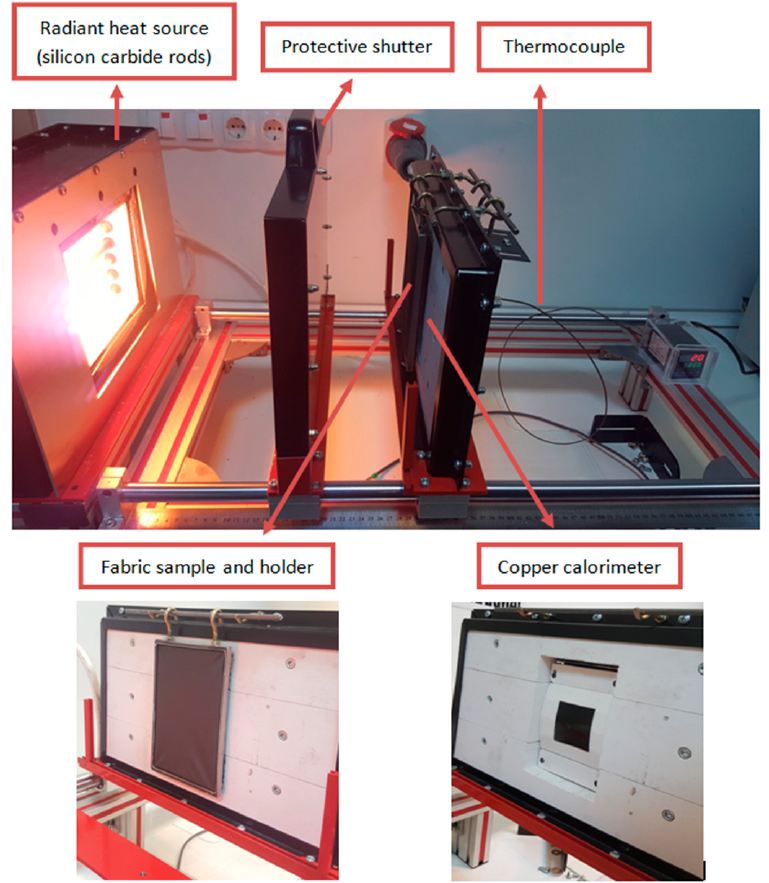
Figure 2. Radiant heat transmission measurement according to the EN ISO 6942 standard [18].